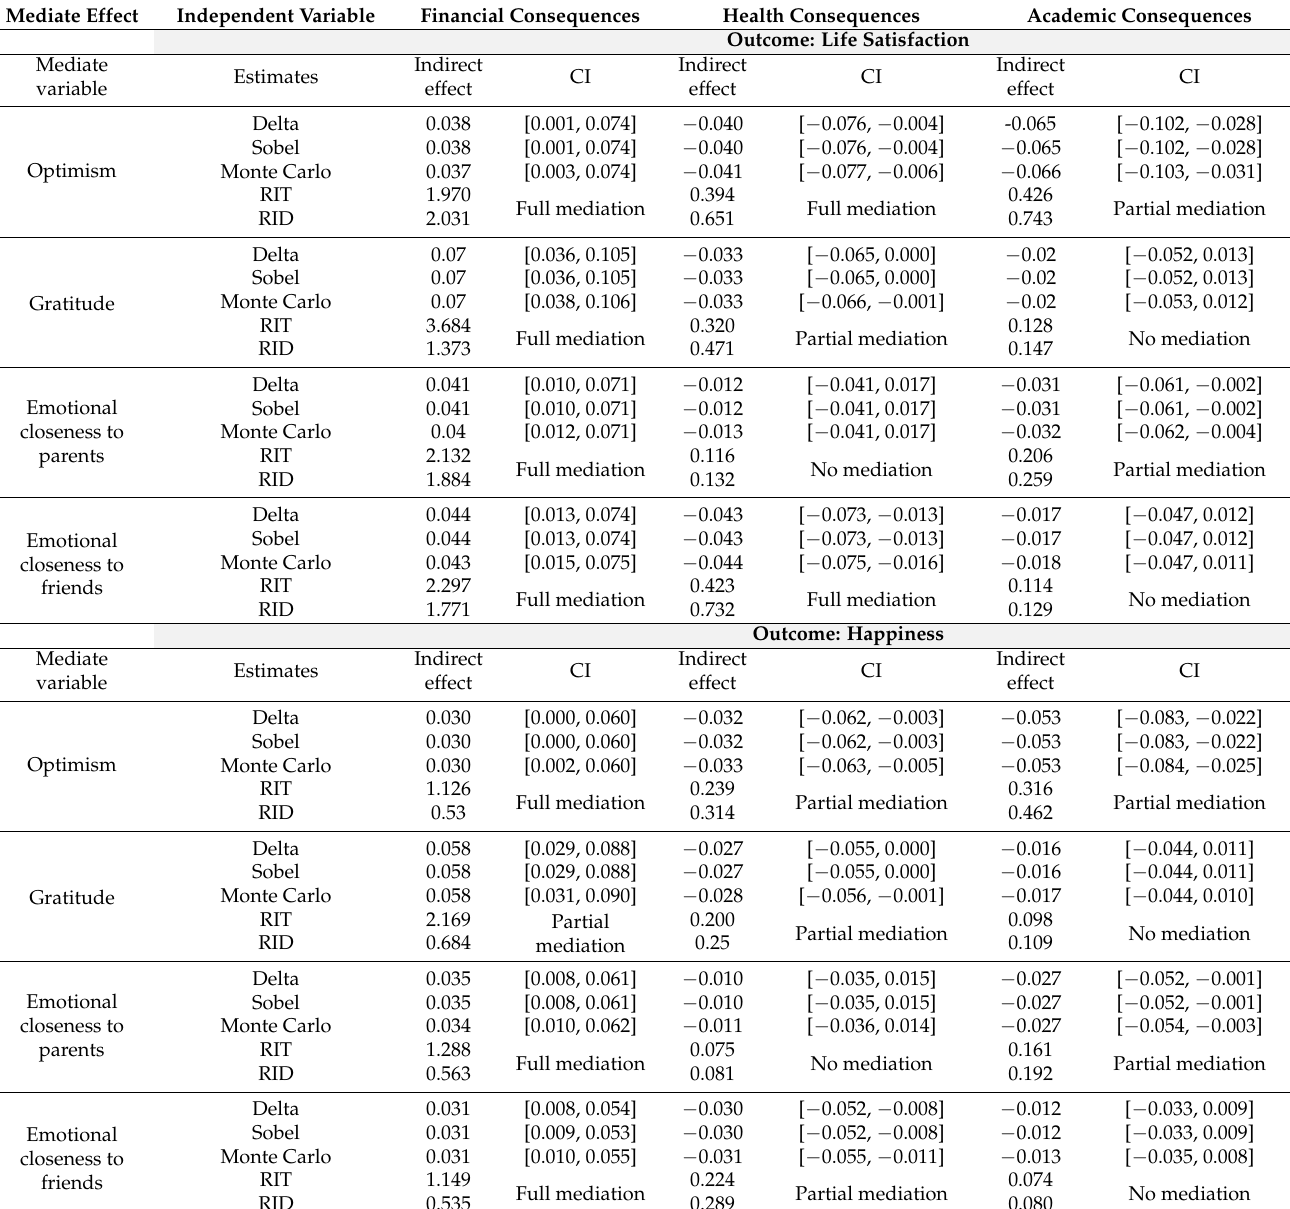
Table 3. Mediate effect of coping strategic on life satisfaction and